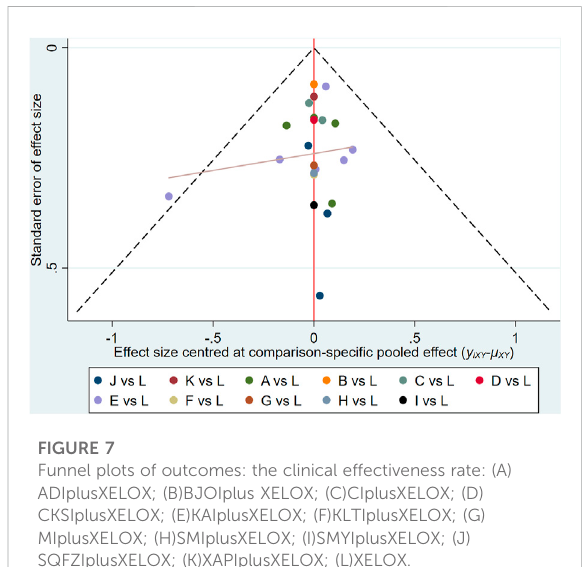
FIGURE 7 Funnel plots of outcomes: the clinical effectiveness rate: (A) ADIplusXELOX; (B)BJOIplus XELOX; (C)CIplusXELOX; (D) CKSIplusXELOX; (E)KAIplusXELOX; (F)KLTIplusXELOX;